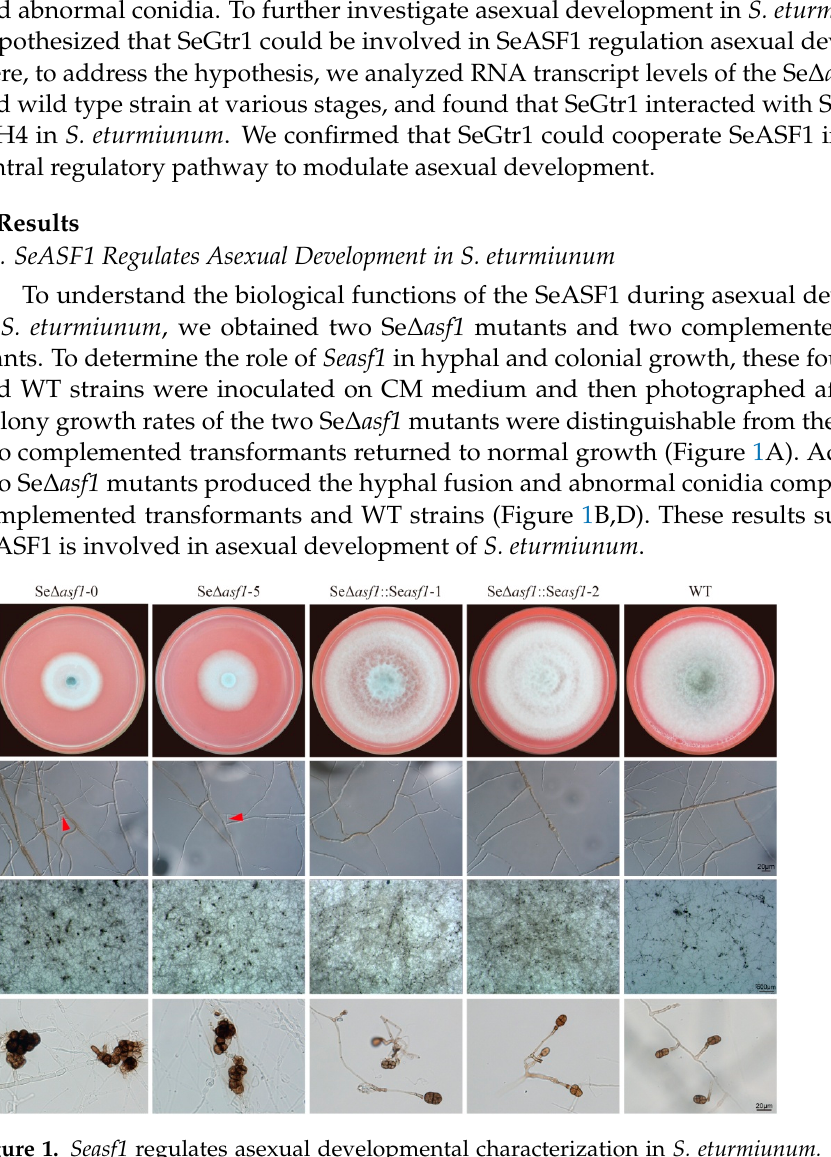
Figure 1. Seasf1 regulates asexual developmental characterization in S. eturmiunum. ( A ) Growth of two Se ∆ asf1 mutants, two Se ∆ asf1 :: Seasf1 transformants, and WT strains on CM medium. The cultures were photographed after 9 days of incubation. ( B ) Characterizations of hyphal fusion in two Se ∆ asf1 mutants, two Se ∆ asf1 :: Seasf1 transformants, and WT strains. The images were photographed after growing on PDA medium for 8 days. The fusions in the hyphae were marked with red arrows. ( C , D ) Conidia morphology of four mutants and WT strains were cultured on CM medium for 4 weeks. Bar = 20 µ m, 500 µ